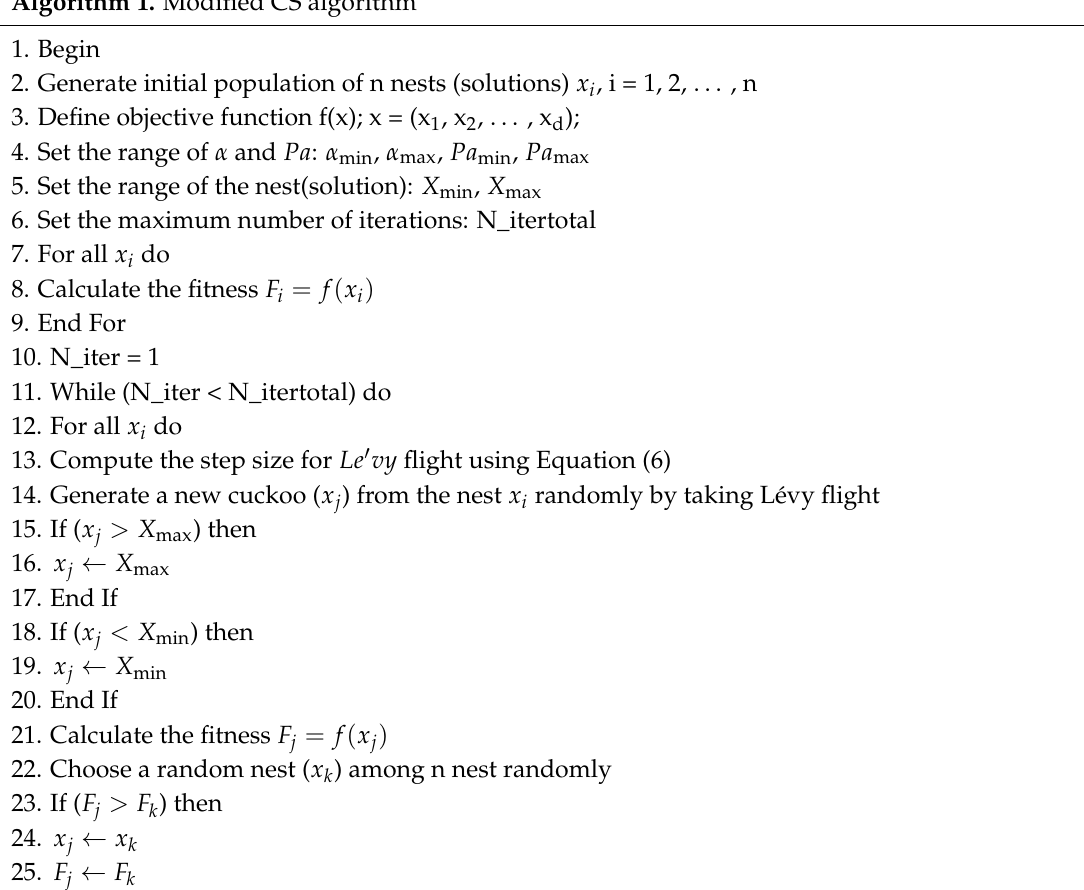
Algorithm 1. Modified CS